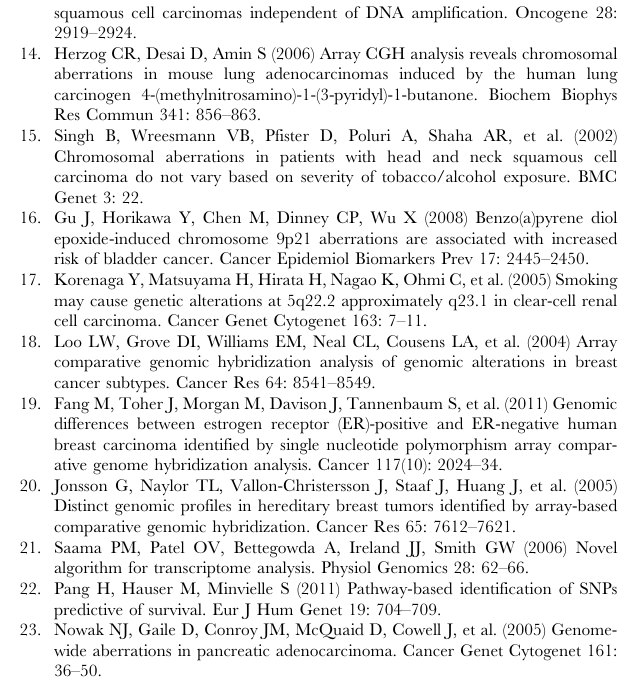
Table S1 Patient and tumor characteristics in relation to betel quid chewing. Table S2 Total 110 regions seen to be altered in overall samples. Table S3 Chromosomal gains and deletions in breast tumors from 26 BQC and 17 NBQC. High-level amplifica- tions are in boldface. Table S4 Regions with chromosomal alterations fre- quent in betel quid chewers and non chewers breast cancer patients. Table S5 DAVID analysis of genes in BQC, NBQC and Common regions. Table S6 Details of betel quid chewing history for